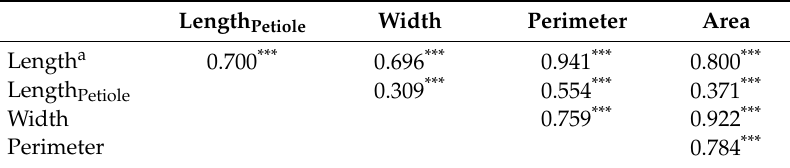
Table 6. Pearson linear correlations between leaf size-related traits ( n = 44).